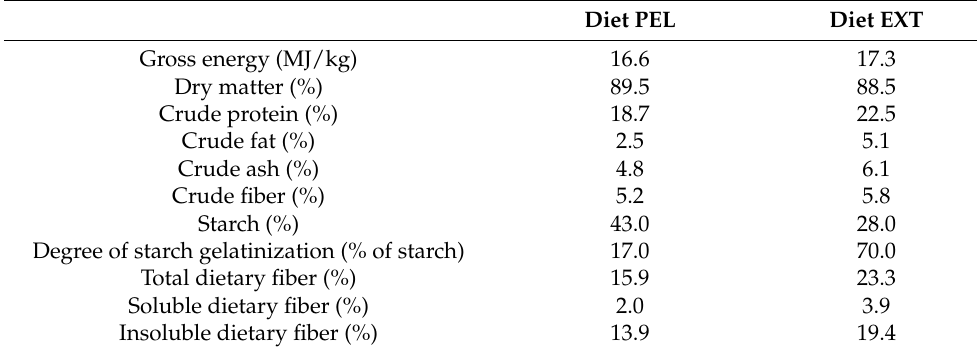
Table 1. Composition of the pelleted (PEL) and extruded (EXT) test diets (as fed basis).